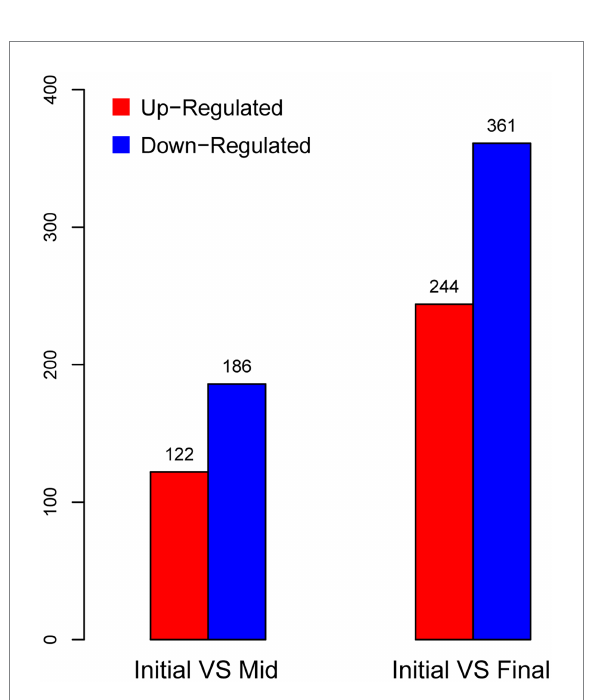
FIGURE 3 Statics of differently expressed genes (DEGs) within treatment